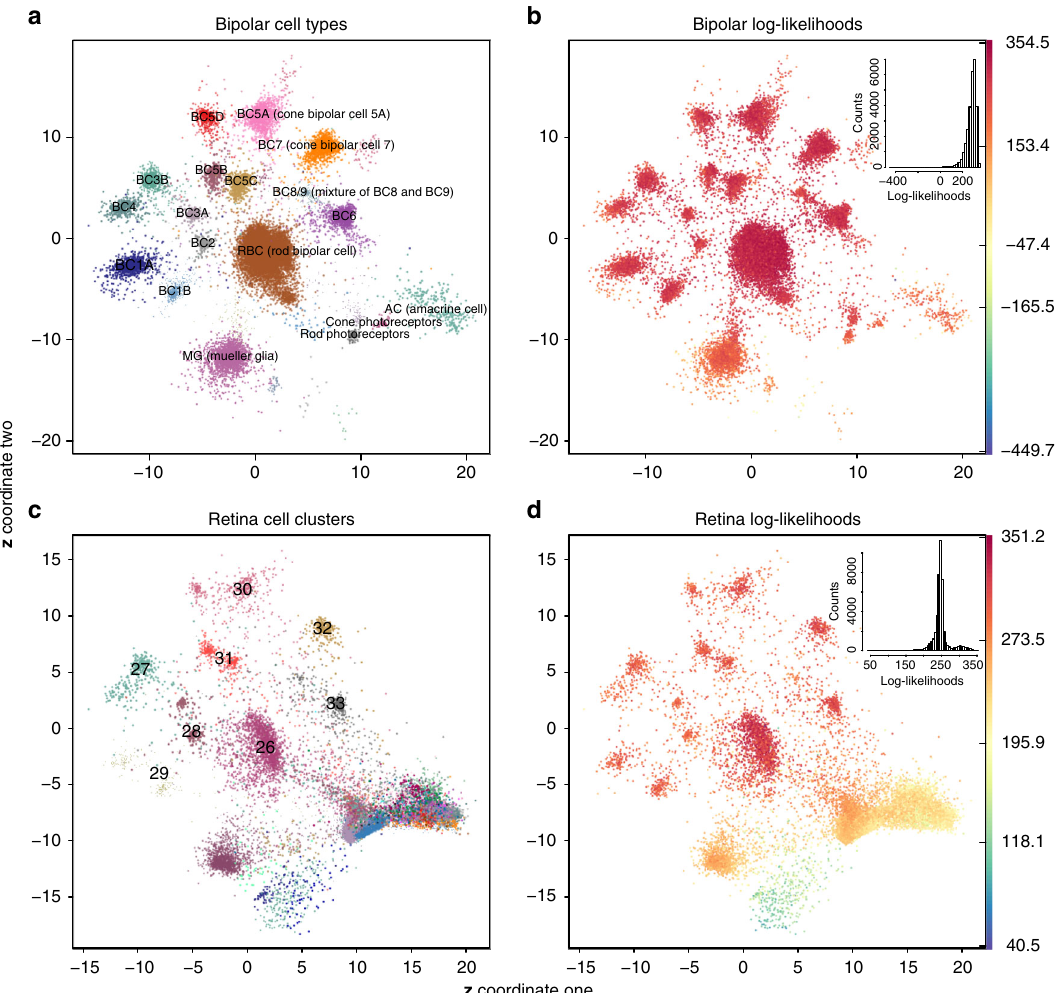
Fig. 4 Learning a probabilistic mapping function from the bipolar data and applying the function to the independently generated mouse retina dataset. a scvis learned two-dimensional representations of the bipolar dataset, b coloring each point by the estimated log-likelihood, c the whole mouse retina dataset was directly projected to a two-dimensional space by the probabilistic mapping function learned from the bipolar data, and d coloring each point from the retina dataset by the estimated